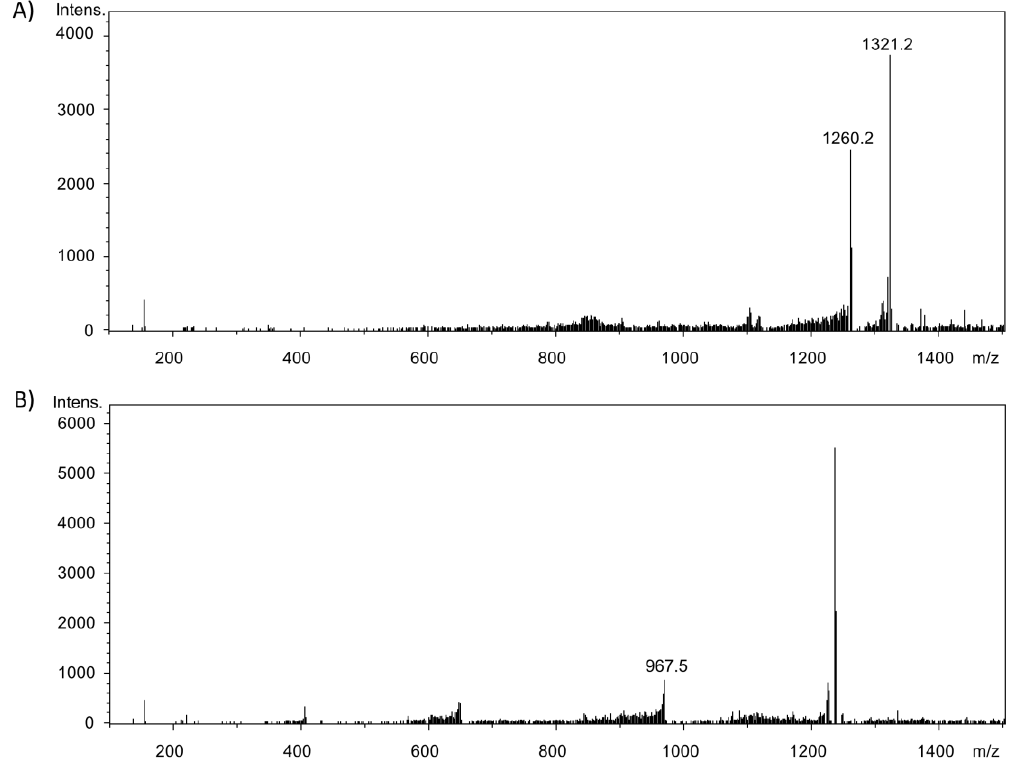
Figure 3. Full scan mass spectra after chromatographic separation via UPLC and detection using ESI-MS. ( A ) Potential adduct formation at retention time 14.6 min; ( B ) Potential adduct formation at retention time 18.5 min.